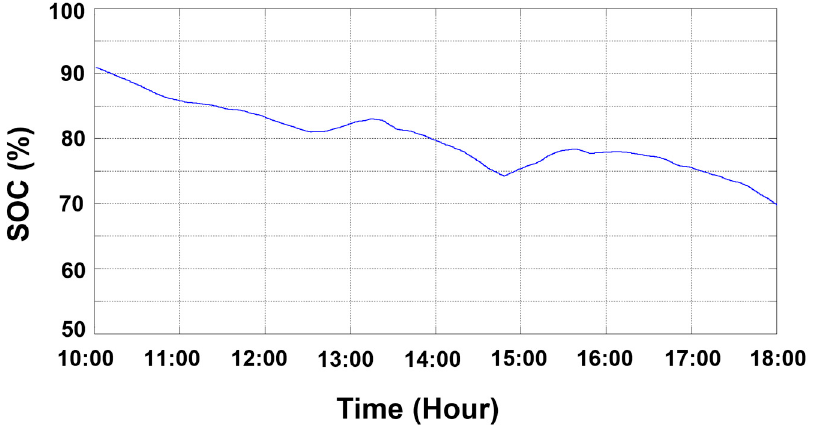
Figure 15. Fuzzy-based EMS in cloudy day: ESS SOC.